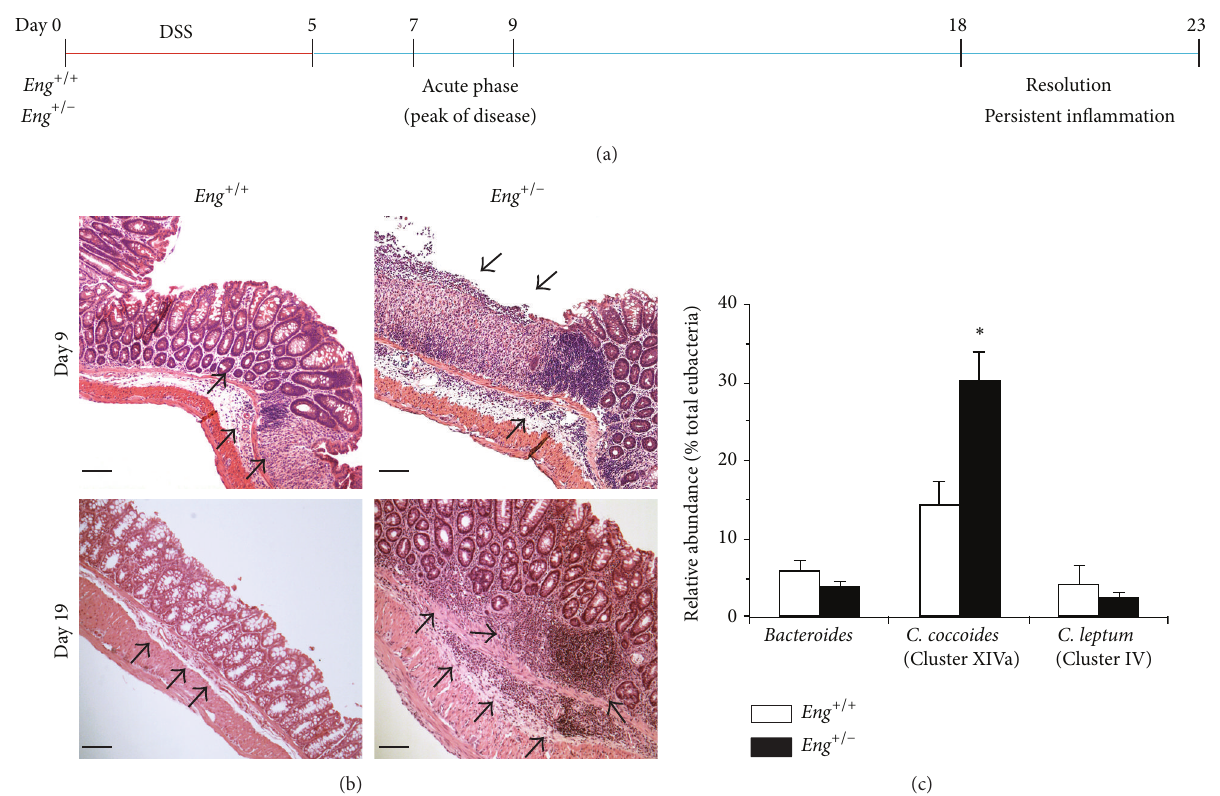
Figure 1: Persistent colonic inflammation in DSS-treated Eng +/− mice is associated with changes in a major gut bacterial group. (a) Eng +/+